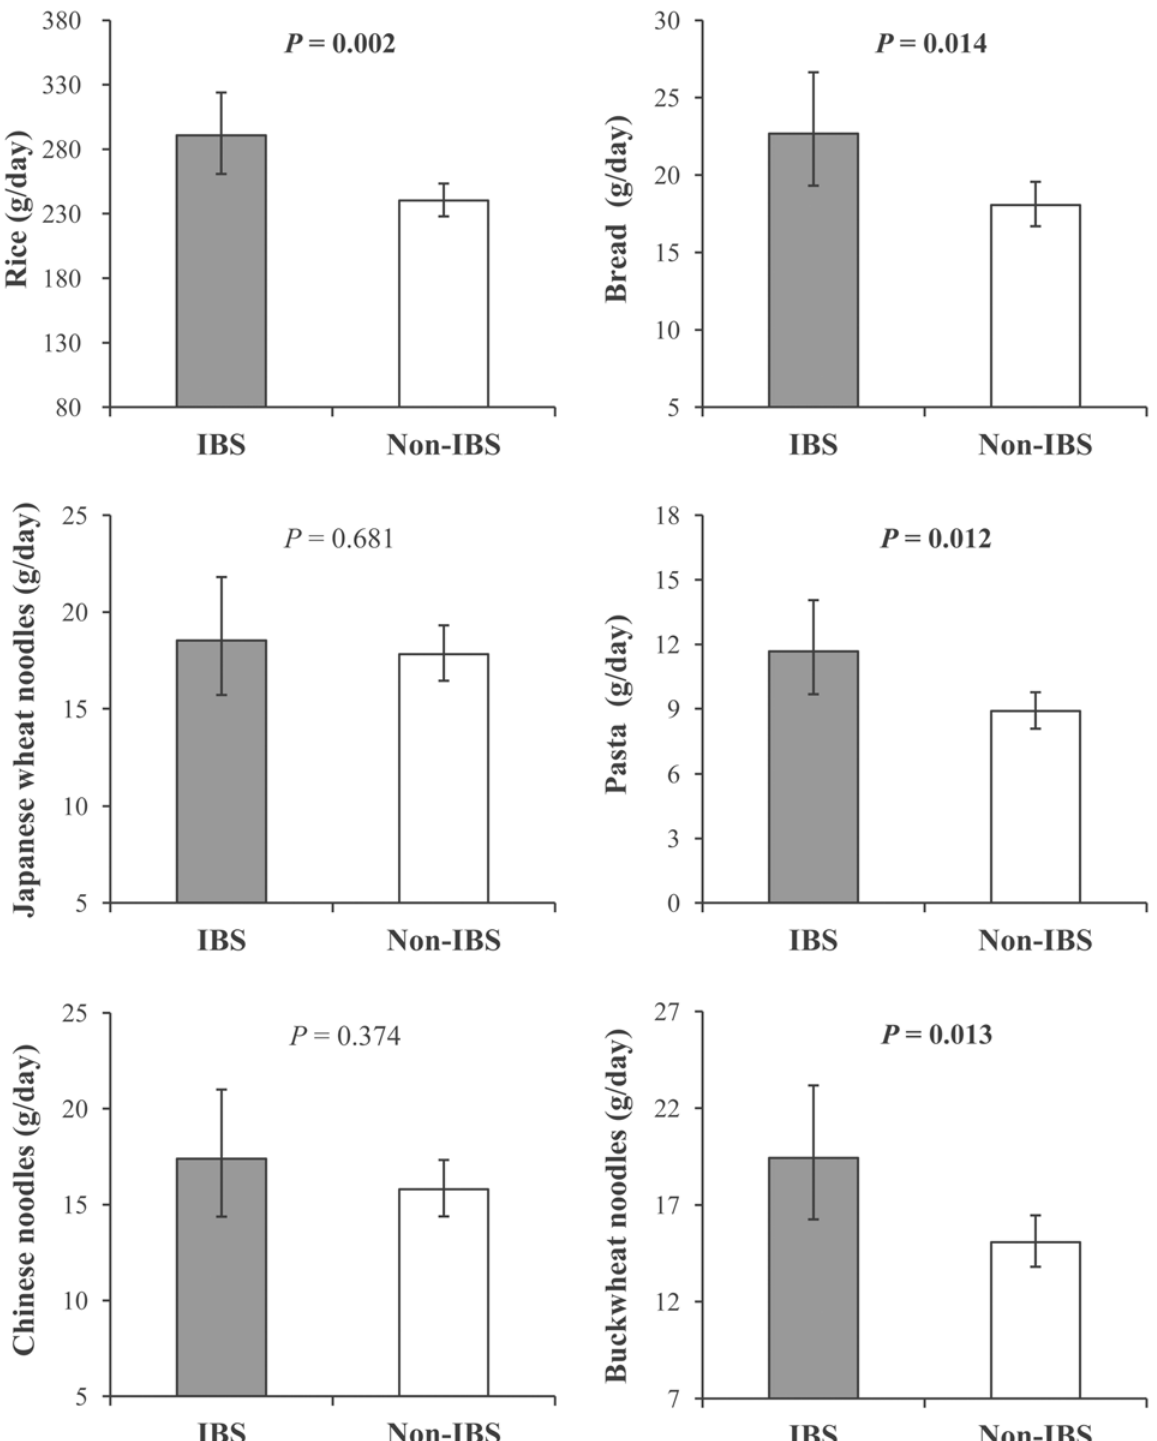
Fig 1. Analysis of Covariance on Association between Staple Foods Consumption and Irritable Bowel Syndrome (IBS) Prevalence. Confounding factors include age (continuous variable), sex, body mass index (continuous variable), smoking status (never, former, current), drinking frequency (never, sometimes, every day), occupation (desk work), educational levels ( (cid:1) college), sleep duration (6 – 8 hours/day), physical activity ( (cid:1) 23 metabolic equivalent hours/week), and depressive symptoms (self-rating depression scale (cid:1) 45 points). Data on the consumption of staple foods were log-transformed prior to multivariate statistical analyses due to their abnormal distribution and back-transformed for data presentation. Data were shown as means and 95% confidence interval. Of the 1 082 subjects, 212 had IBS.